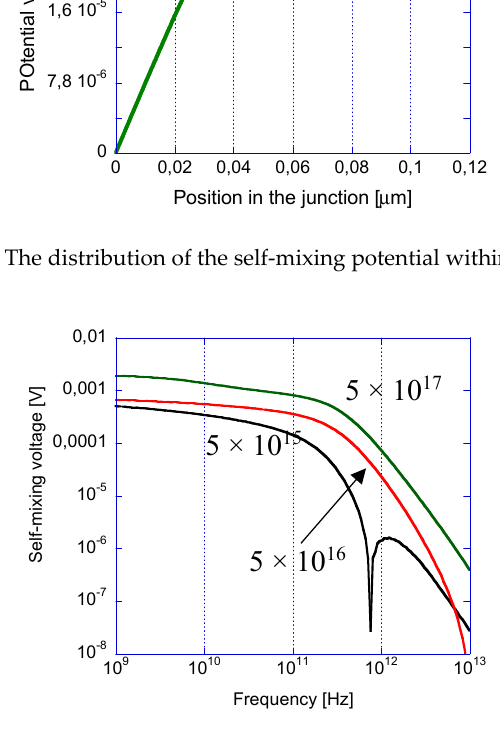
Figure 5. The frequency behavior of the DC self-mixing voltage generated through the structure, with different values of doping of the n layer in cm − 3